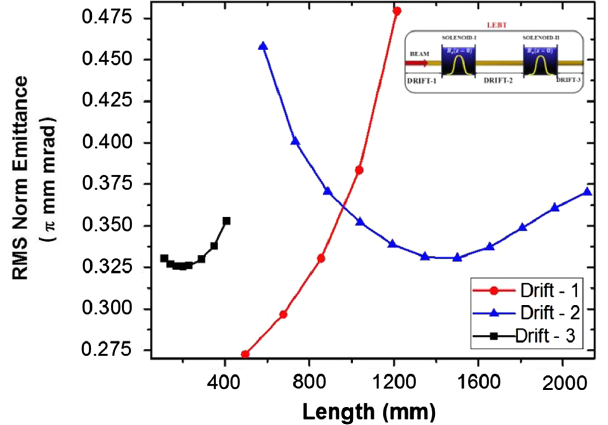
FIG. 4. RMS normalized beam emittance at the output of the LEBT for a matched beam as a function of drift-1, drift-2 and drift-3.